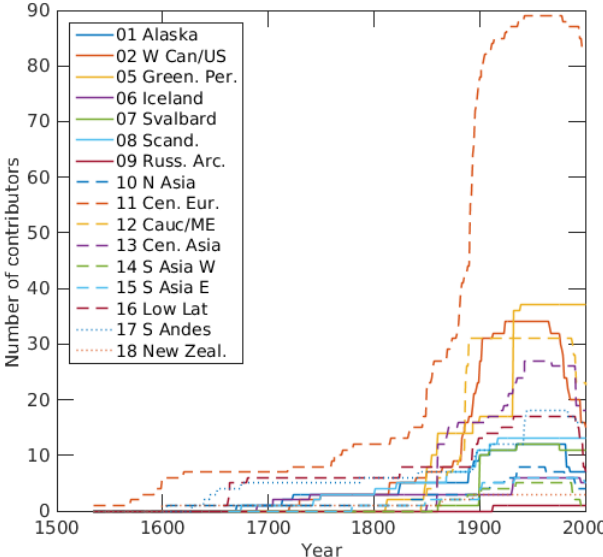
Figure 2. Number of glaciers contributing to the Leclercq et al. (2014) dataset regional mean (Fig. 3, black line) over time, by RGI region ID. This does not include the 91 glaciers that are excluded from the regional means for being marine- or lake-terminating, and thus the total number of glaciers shown here is